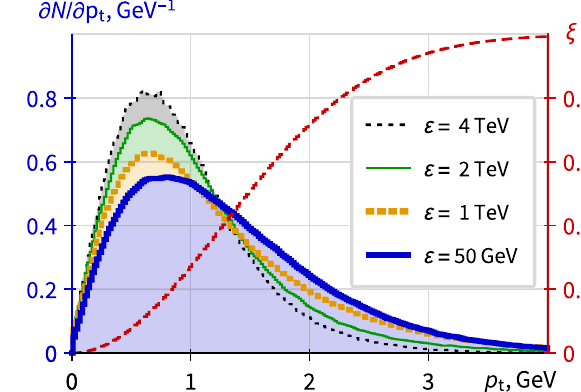
momentum of all Λ c produced in a fixed target by 6 . 5TeV protons, histograms (right plot) – same for specific energies of Λ c indicated on the right. Here the polarisation is projected on the p Λ